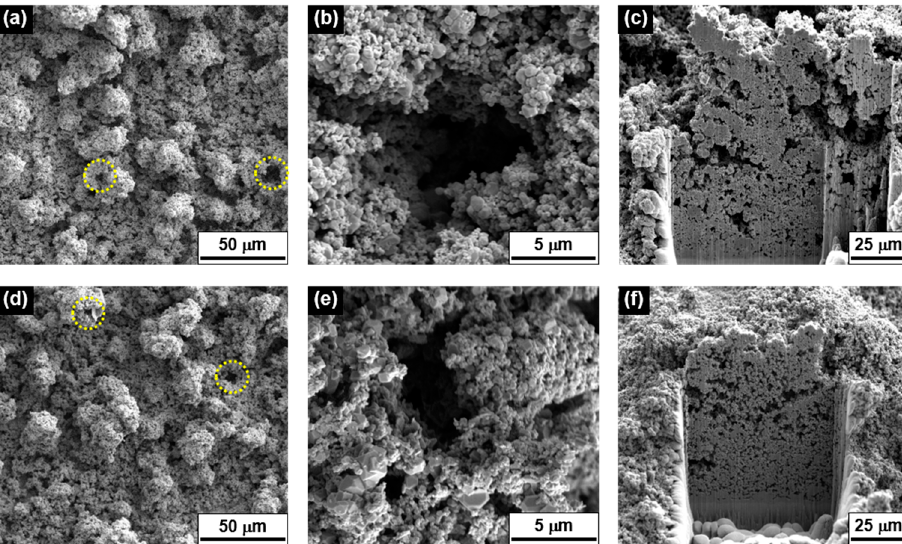
Figure 6. SEM micrographs of fuel deposits formed ( a – c ) under the condition of Case #3, and ( d – f ) after the subsequent exposure of the deposits formed under the condition of Case #3 to the 60 ppb of zinc coolant under the condition of Case #4. ( b , e ) show examples of large boiling chimneys. ( c , f ) are the cross ‐ sections of the deposits machined using the focused ion beam (FIB) technique.